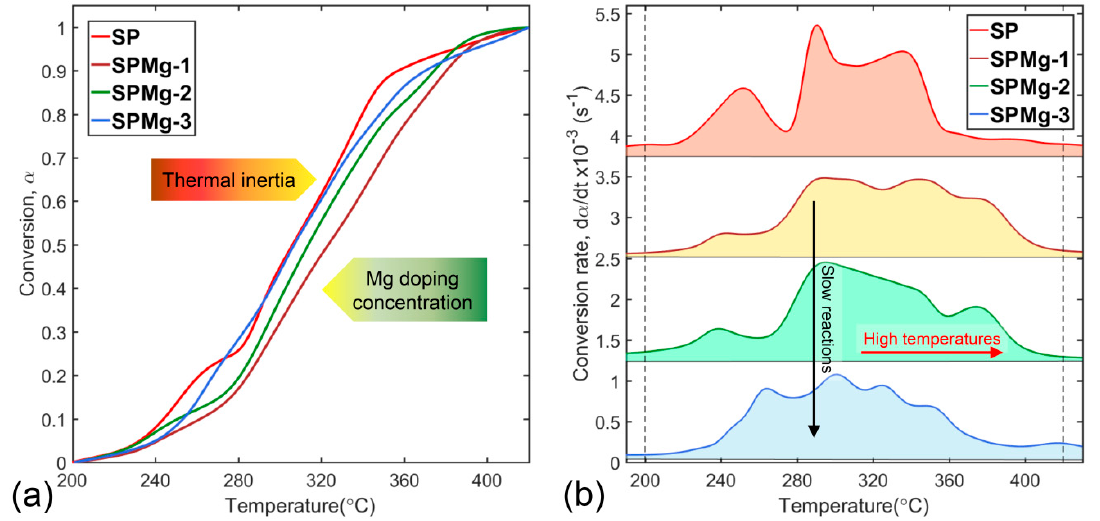
Figure 3. Curves of ( a ) conversion and ( b ) conversion rates’ evolution of synthesis precursors with different magnesium doping concentrations.